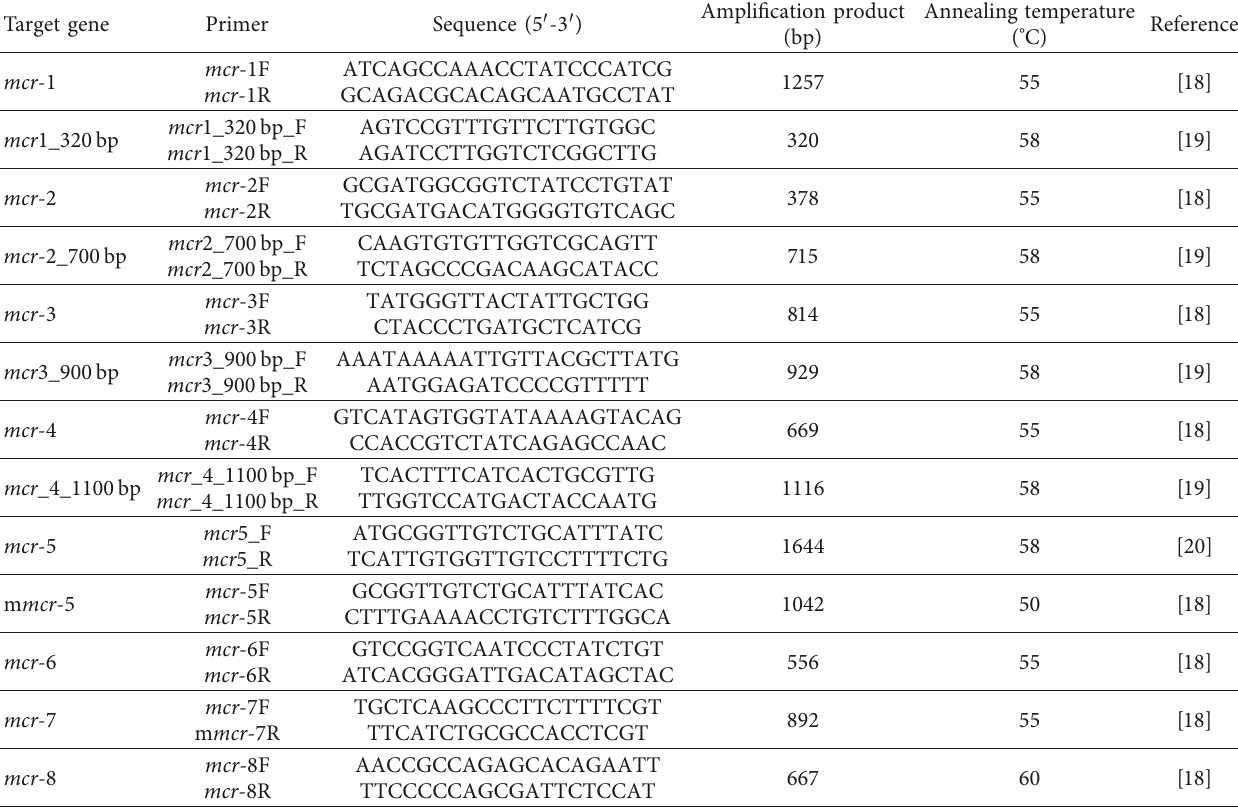
Table 2: Primers for detection of colistin-resistant genes.